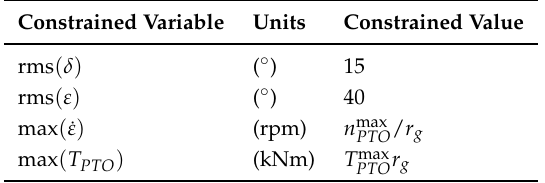
Table 3. Technological constraints, fulfilled by tuning the control parameters.